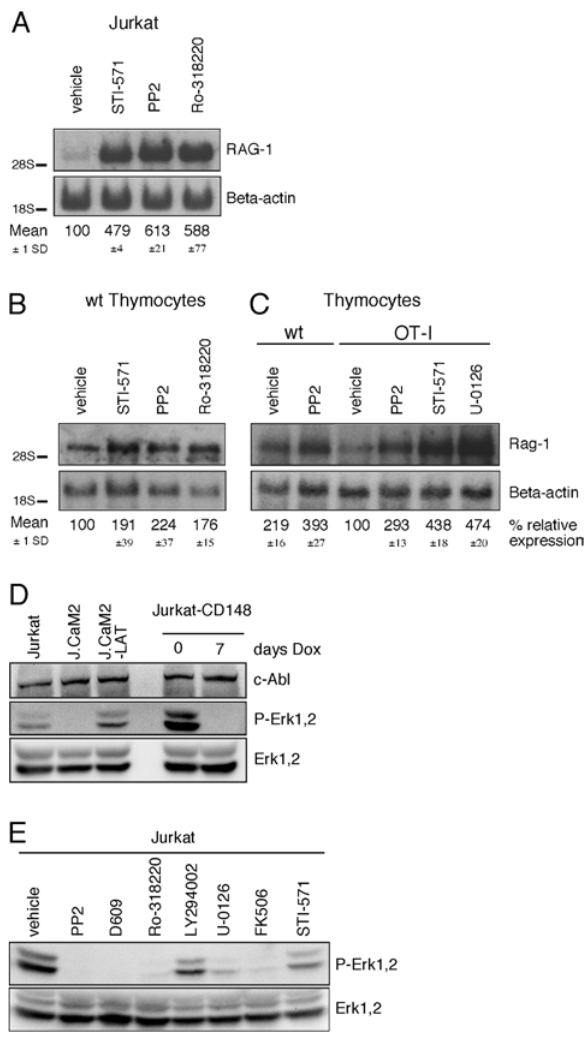
Figure 5. Erk and Abl Kinases Transduce Repressive Signals That Control RAG Gene Expression (A) Northern blot analysis for RAG-1 gene expression in STI-571- treated Jurkat T cells and comparison to PP2- or Ro-318220-treated samples. (B) Wild-type thymocytes were treated with the indicated inhibitors for 20 h and analyzed for Rag-1 expression. (C) Northern blot analysis of Rag-1 expression in inhibitor-treated TCR transgenic OT-I thymocytes or wild-type thymocytes of littermate controls. The relative expression level of Rag-1 was calculated from two independent experiments, and the mean expression and standard deviation (SD) are indicated. (D) Western blot analysis using RIPA lysates of the indicated cell lines. Protein levels of phosphorylated Erk-1 and Erk-2, Erk-1 and Erk-2, and c-Abl were determined in 4 3 10 6 resting cells per sample. (E) Analysis of phospho-Erk-1 and Erk-2 levels in Jurkat T cells treated for 24 h with the indicated inhibitors prior to RIPA lysis. Equal loading is indicated by Erk-1 and Erk-2 levels determined by stripping and reprobing the same